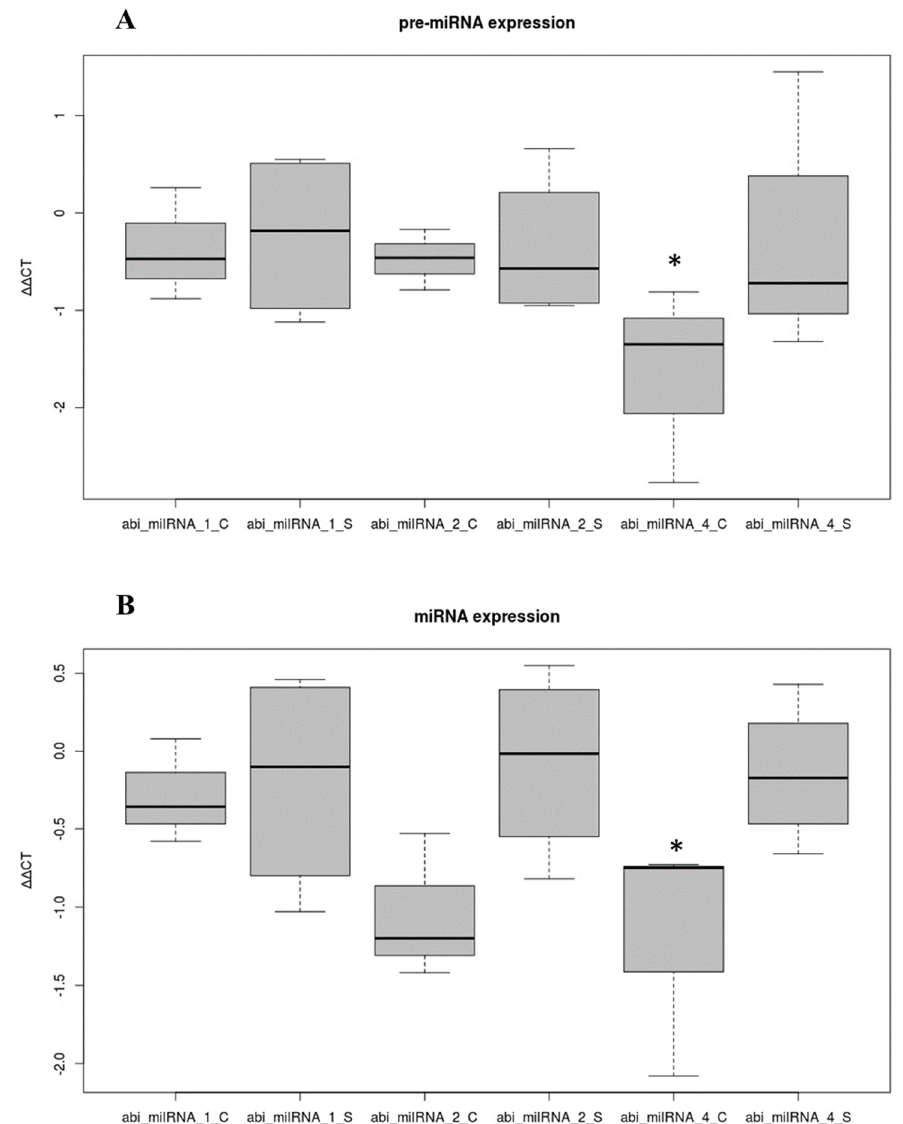
Figure 6. Verification of pre − miRNAs and miRNAs by RT − qPCR. ( A ) Differential expression of abi_milRNA_1a, abi_milRNA_2a and abi_milRNA_4a pre − miRNAs in stipe (S) and cap (C). ( B ) Differential expression of abi_milRNA_1a, abi_milRNA_2a and abi_milRNA_4a mature miRNAs in stipe (S) and cap (C). *: Results are statistically significant at α : 0.1.